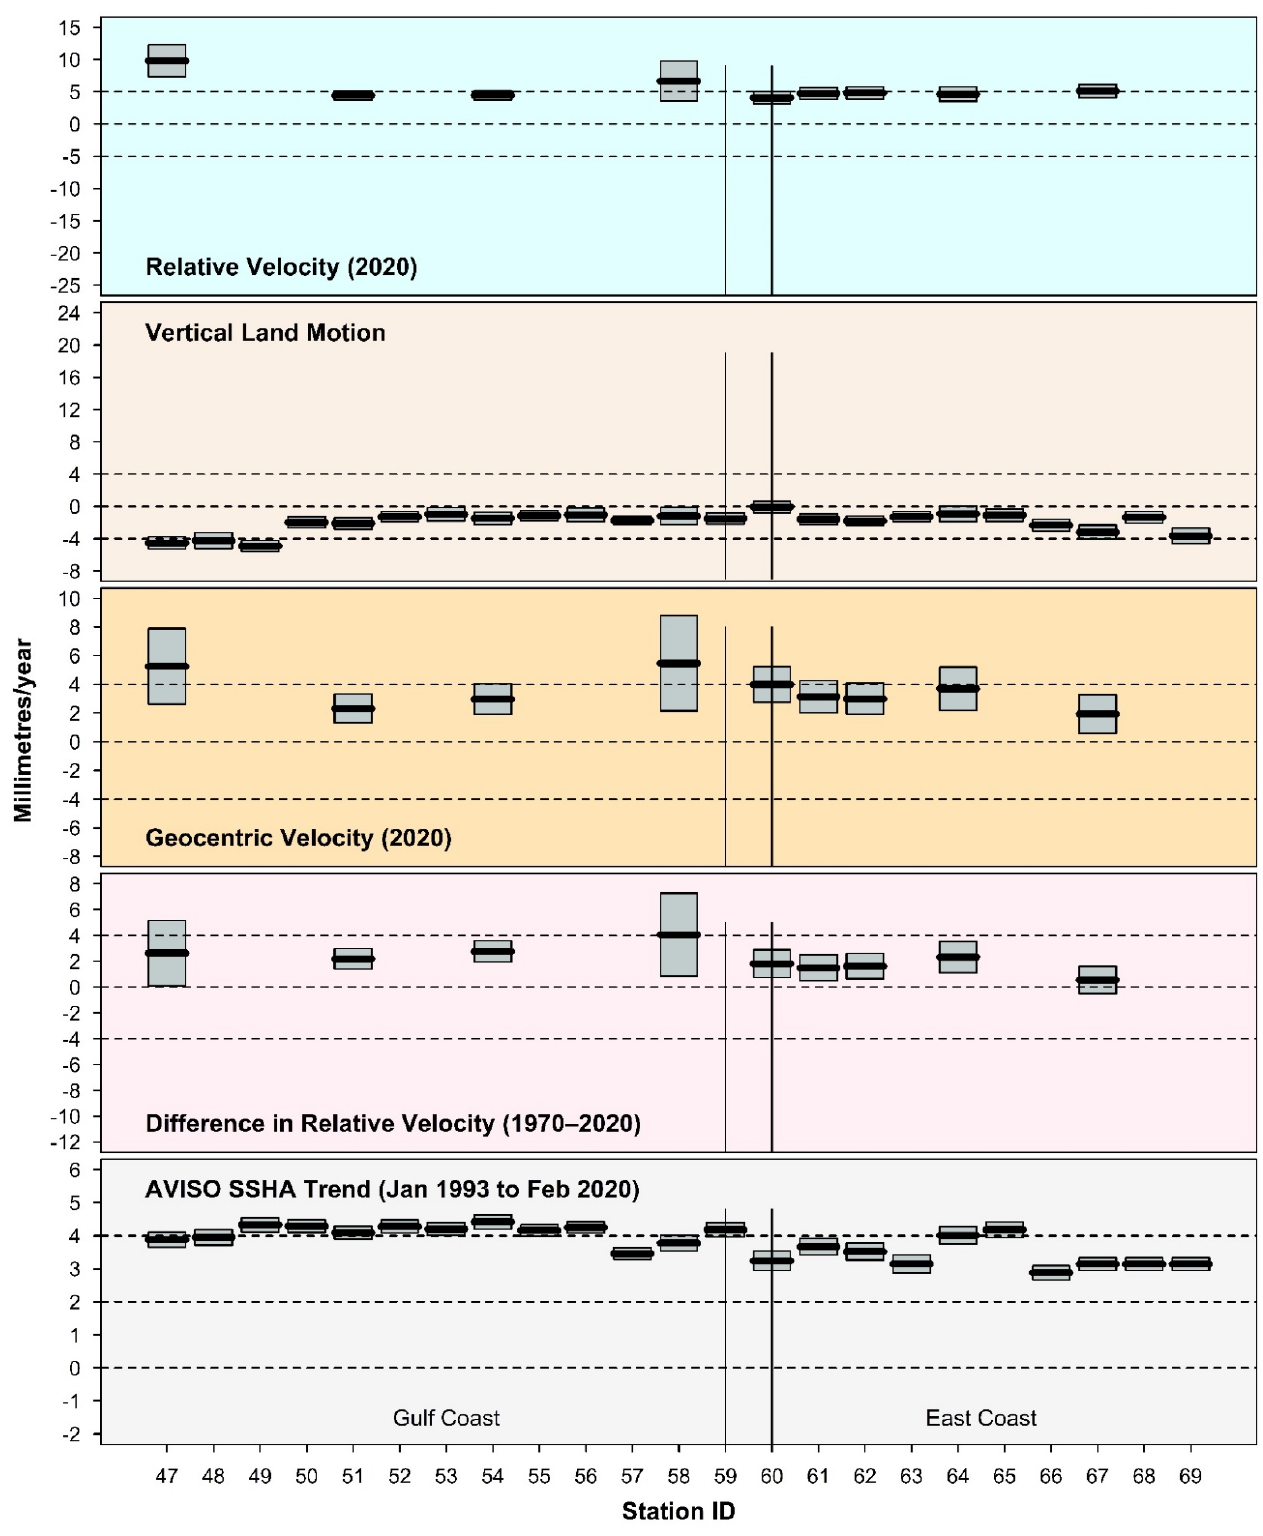
Figure 4. Summary of results for Station ID’s 47–69. Refer to Figure 1 and Table 1 for station ID details. Shaded boxes represent 95% CL for each set of results. Vertical lines demarcate respective sectors of coast which are denoted in the bottom panel. For details on the methodology underpinning the respective charts, refer Section 2.